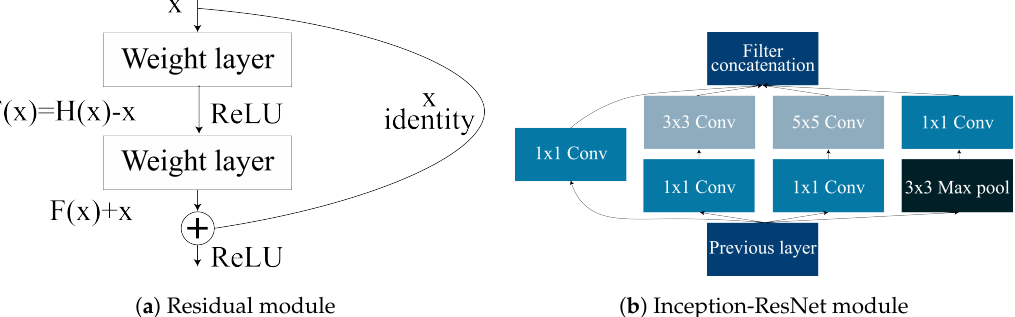
Figure 3. ( a ) Module learned to converge H ( x ) − x to zero. ( b ) 1 × 1 convolutions are used to compute reductions before the expensive 3 × 3 and 5 × 5